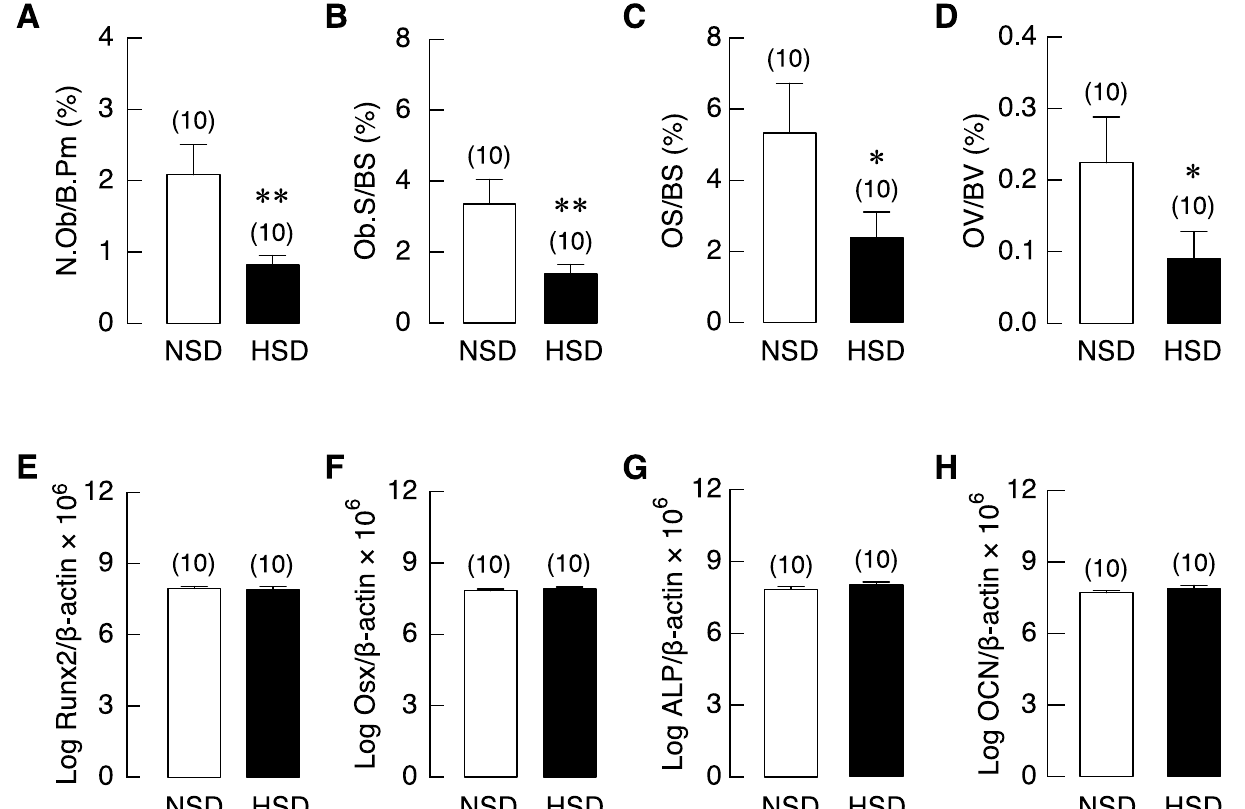
Figure 8. Bone histomorphometric analysis of tibiae and the mRNA expression levels of bone formation markers in long bone (humerus and radius) of NSD and HSD. ( A ) Percentages of osteoblast number per bone perimeter (N.Ob/B.Pm), ( B ) osteoblast surface per bone surface (Ob.S/BS), ( C ) osteoid surface per bone surface (OS/BS) and ( D ) osteoid volume per bone volume (OV/BV). The mRNA expression of ( E ) Runx2, ( F ) Osterix (Osx), ( G ) alkaline phosphatase (ALP) and ( H ) osteocalcin (OCN) were determined by quantitative real-time PCR and was normalized by β-actin expression. Data were analyzed by unpaired t-test. Mostly from cells of the osteoblast lineage in HSD group were similar to those in NSD controls. Numbers in parentheses are numbers of animals in each group. * P < 0.05, ** P < 0.01 compared to period-matched